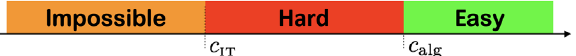
FIG. 1. The schematic phase diagram for hard inference problems showing an information-to-computational gap. The SNR here is given by the graph mean degree c . While for c < c it is impossible to detect the planted signal, for c > c IT is in principle possible, but any known algorithm requires a much larger SNR c > c to achieve signal detection. The value of c alg depends on the algorithm, and the present work aims to estimate it for simulated annealing